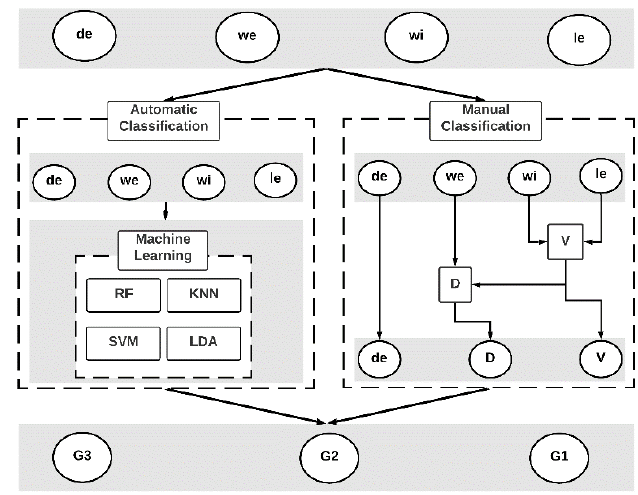
Figure 10. The process of classification system using machine learning. Table 1. Standard type mango.